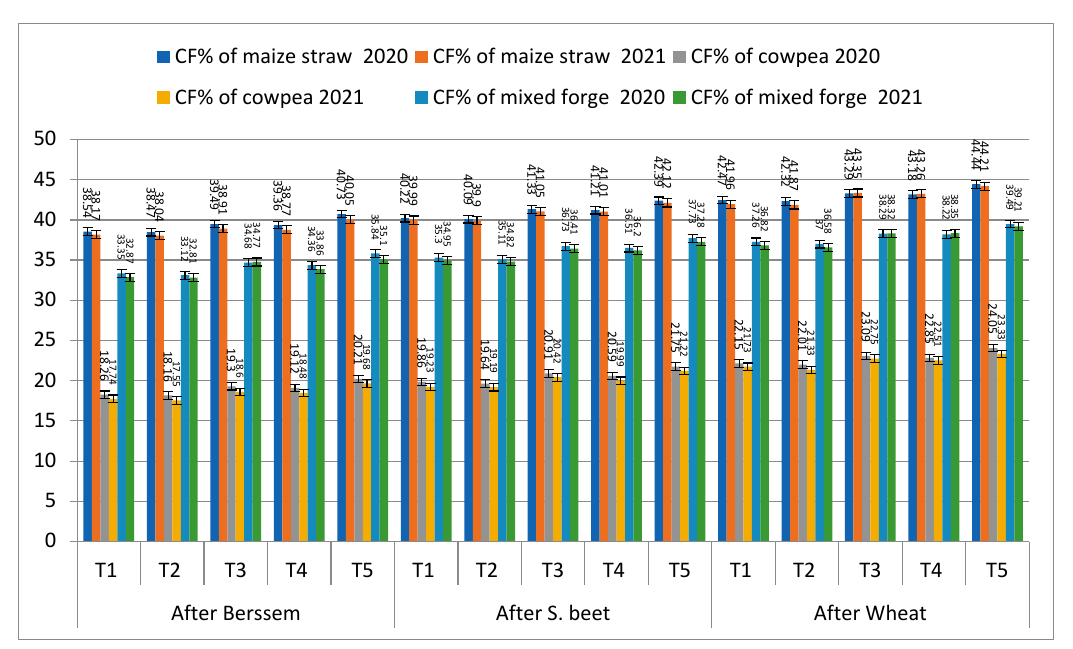
Figure 5. The effect of preceding crops and NPK as well as biofertilizers on the crude fiber percentage of maize straw intercropping with forage cowpea and mixed during 2020 and 2021 seasons. T1: 100% mineral NPK, T2: 75% mineral NPK + Arbuscular Mycorrhiza fungi, T3: 50% mineral NPK + Arbuscular Mycorrhiza fungi, T4: 75% mineral NPK + Mycrobein, T5: 50% mineral NPK + Mycrobein.